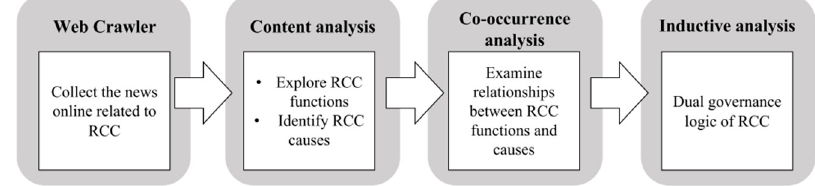
Figure 2. The research framework.